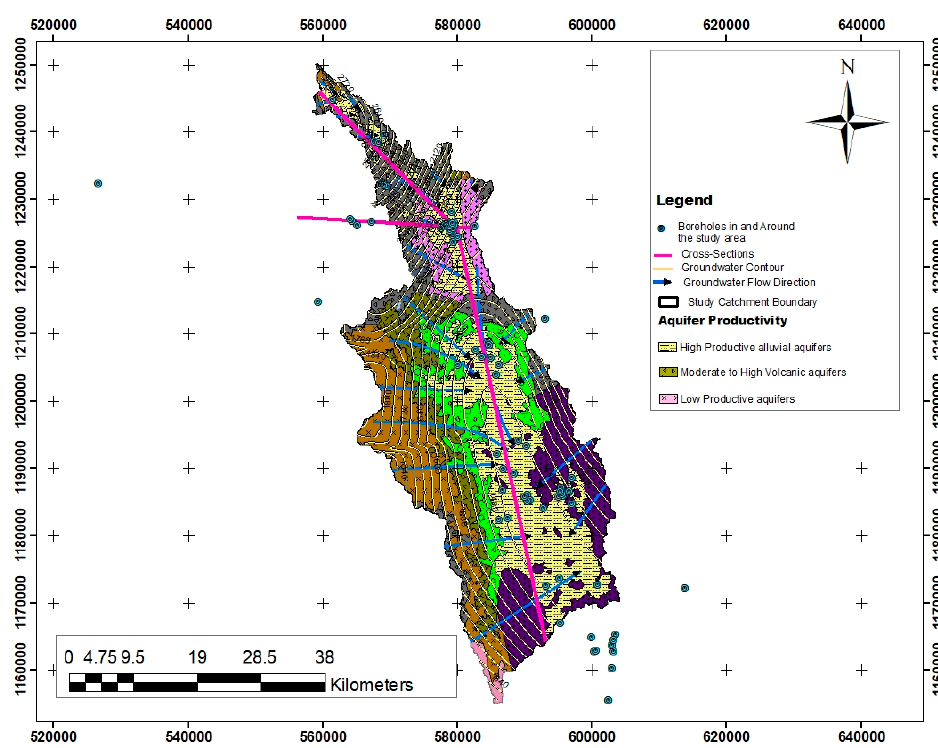
Figure 1. Location map of Borkena Catchment.